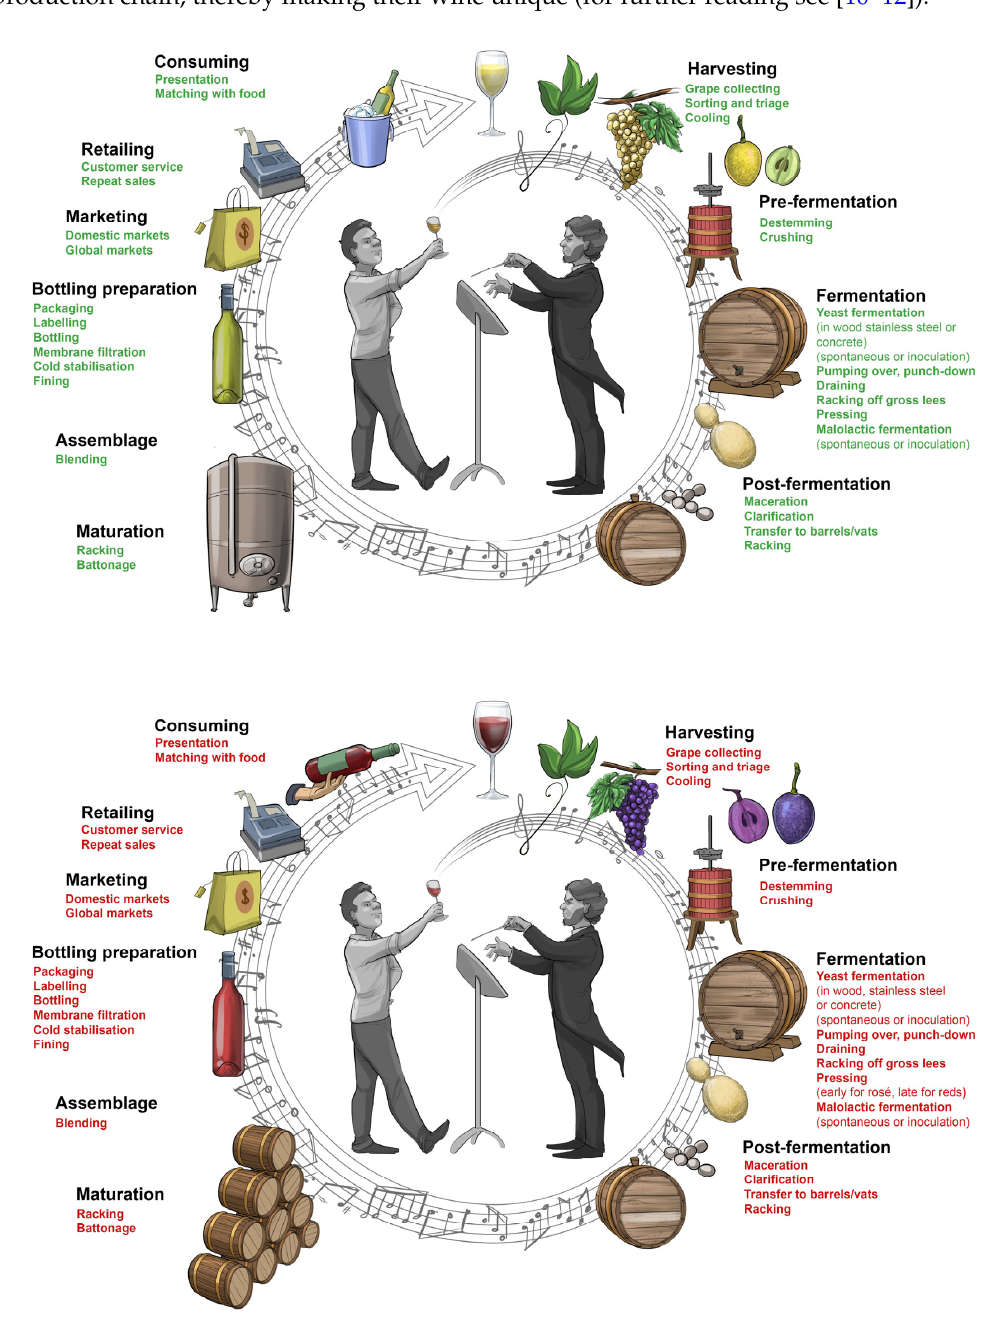
Figure 7. The main steps in the production of red and white wine (adapted from [13]). Some steps, and the sequence thereof, differ between the production of red and white